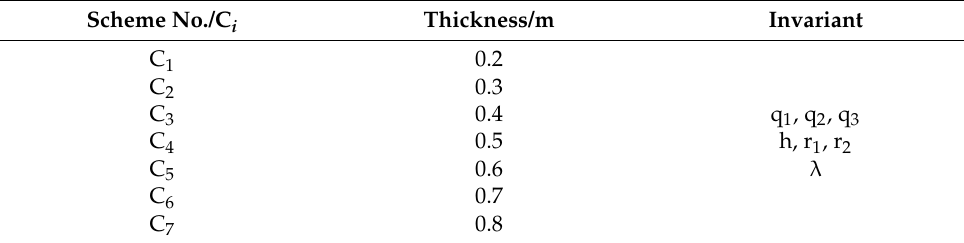
Table 3. Analysis scheme of different lining